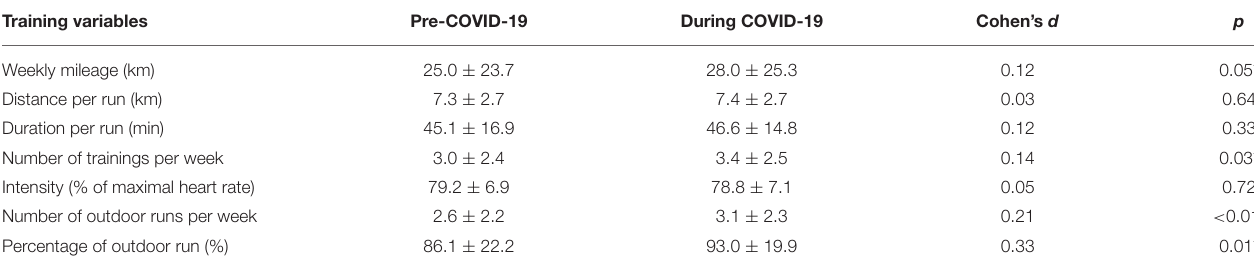
TABLE 3 | The impact of COVID-19 restrictions on running training variables before and the implementation of restrictions. Training